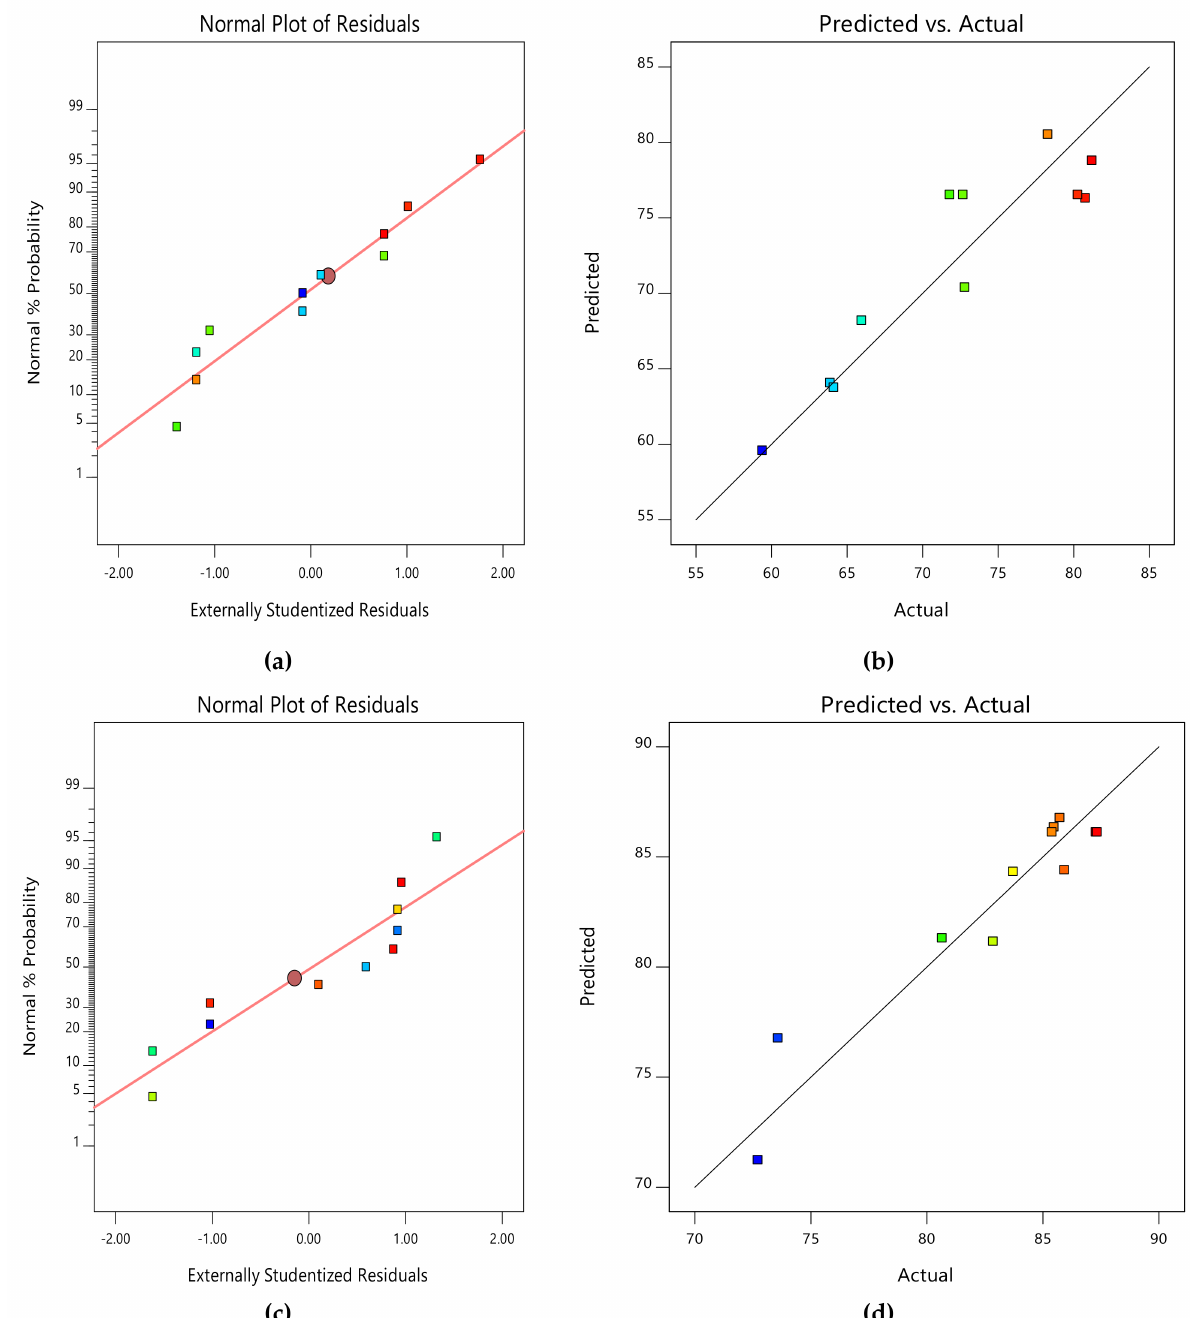
Figure 8. Normal plots of residuals and predicted versus actual plots of CMAS bioreactor for COD ( a , b ) and NH 4 + − N ( c , d )